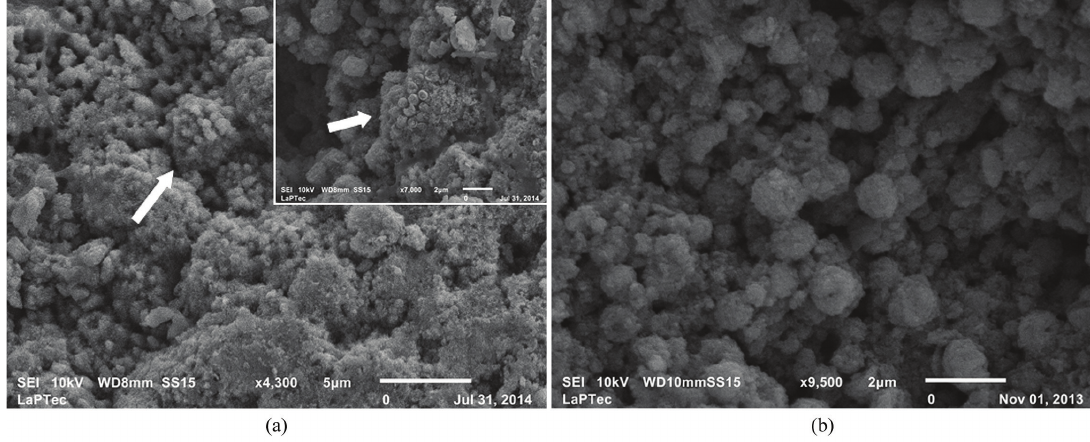
Figure 6. Photomicrographs of the minerals which constitute the fossils from the Crato Formation. (a) Exoskeleton replaced by pseudomorphs of framboidal pyrite (indicated by arrow; detail of a well preserved pseudomorph). (b) Interior of the fossil, with preserved framboidal pyrite pseudomorps.